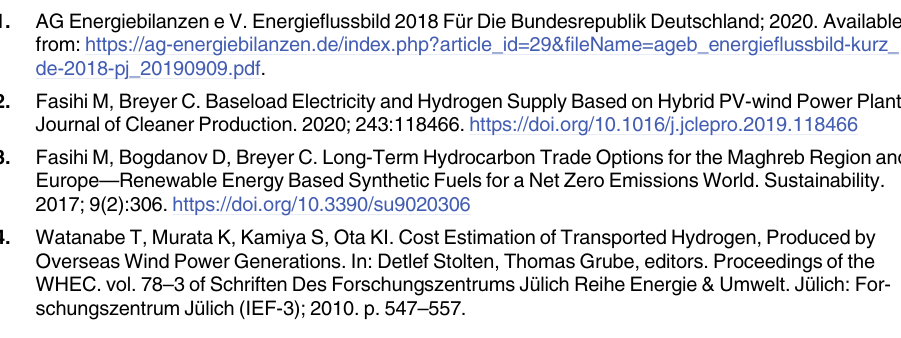
S2 Fig. Electricity generation mix and supply curves. S3 Fig. Cost composition for other years, lower WACC. S4 Fig. RES eligible area masks. S1 Table. Tabular results: Levelised Cost of Energy. (PDF) S2 Table. Tabular results: Levelised Cost of Hydrogen. (PDF) S3 Table. Technology assumptions. (PDF) S4 Table. Conversion efficiencies. (PDF) S5 Table. Shipping